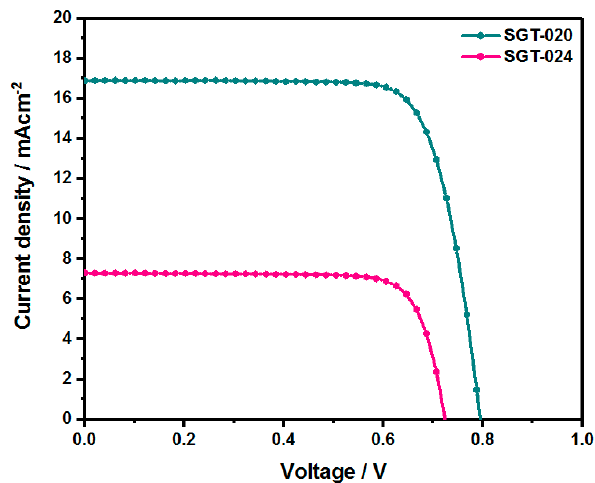
Figure 5. Current ‒ voltage characteristics of the SGT-020 and SGT-024 -based DSSCs with HC-A1 under 100 mW cm − 2 simulated AM 1.5G solar light.